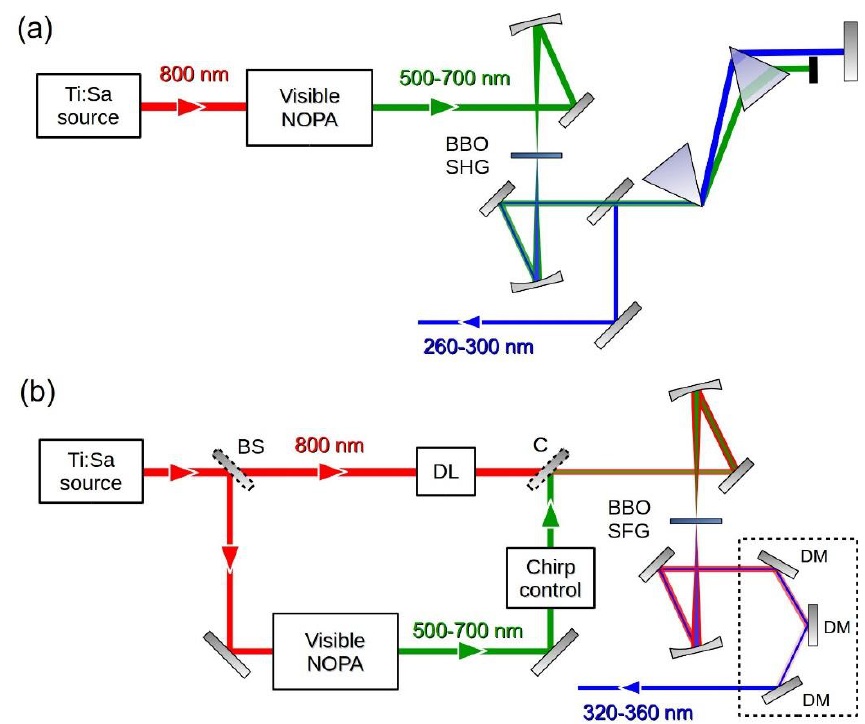
Figure 1. Experimental setup for the generation of few-optical-cycle UV pulses, based on: (a) SHG of the NOPA pulse and (b) SFG between the NOPA pulse and a fraction of the FW laser source. DL: delay line; DM: dichroic mirror; C: combiner.